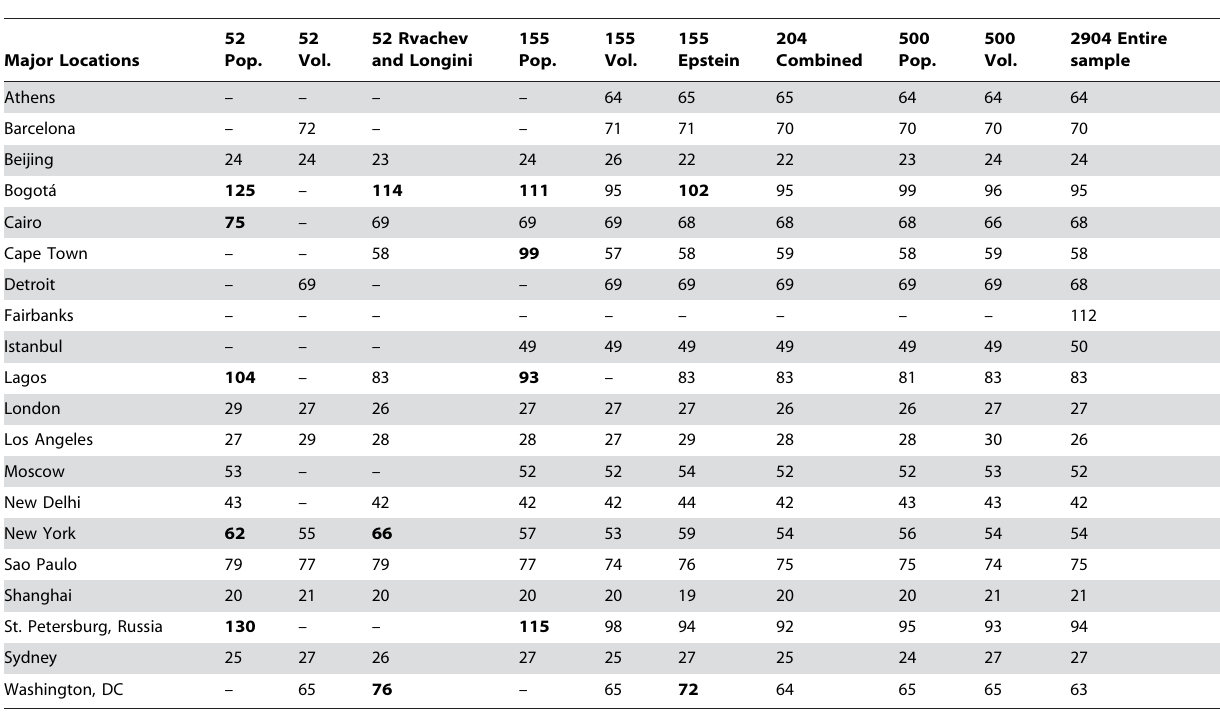
Table 2. First passage times (in days) to selected cities, assuming the epidemic originated on January 1 in Hong Kong.